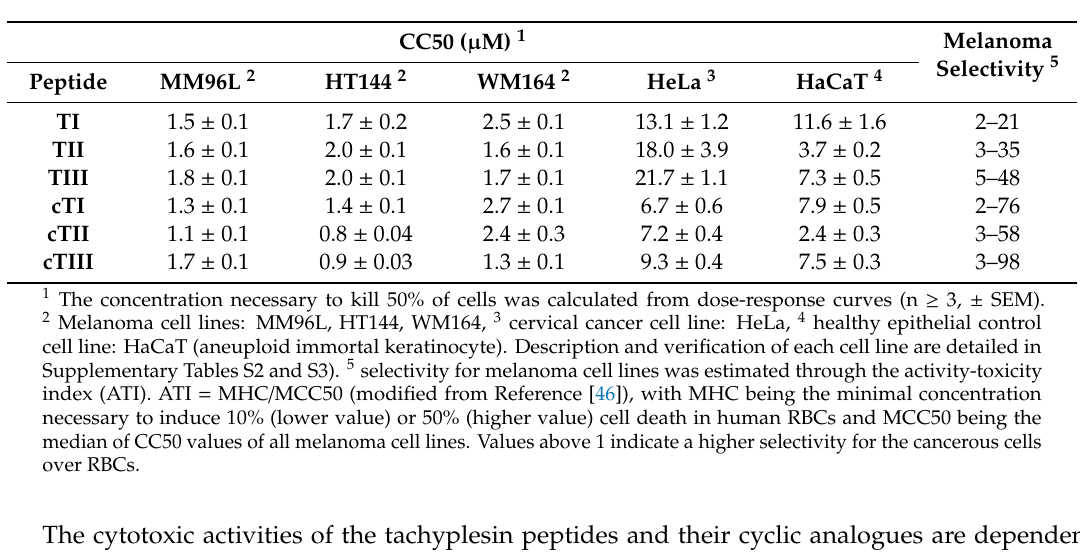
Table 5. The cytotoxicity of tachyplesin I–III (TI-TIII) and cyclic analogues (cTI-cTIII) against cultured